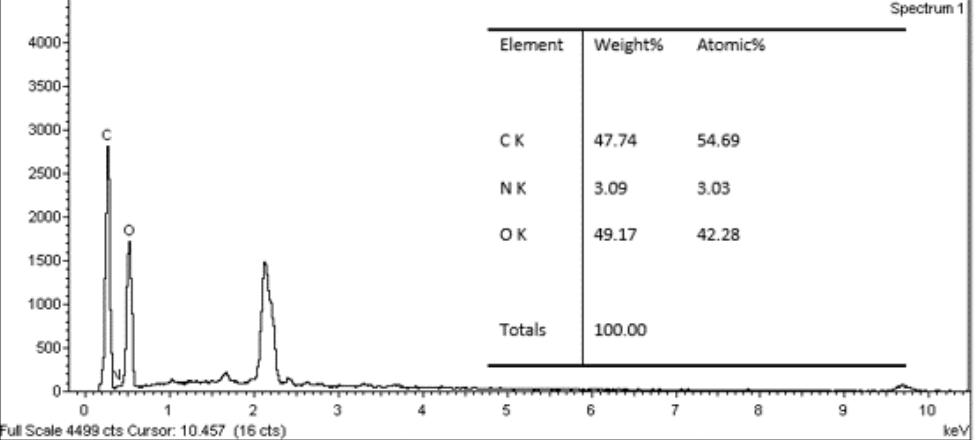
Figure 12. Energy dispersive X-ray spectrum for Rhizophora spp. particleboard bonded with 12% binders.